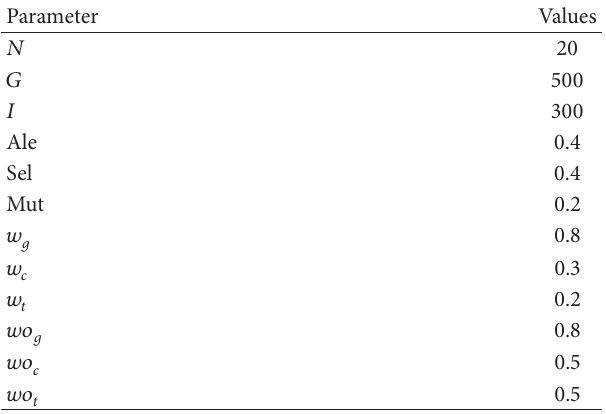
Table 6: TriGen algorithm control parameters for Mouse GDS4510 Dataset.